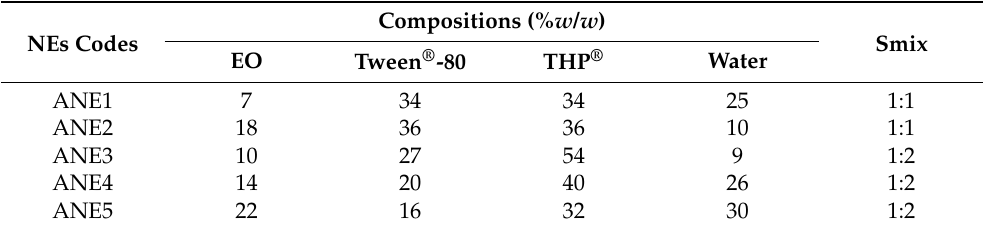
Table 3. Composition of APL-loaded